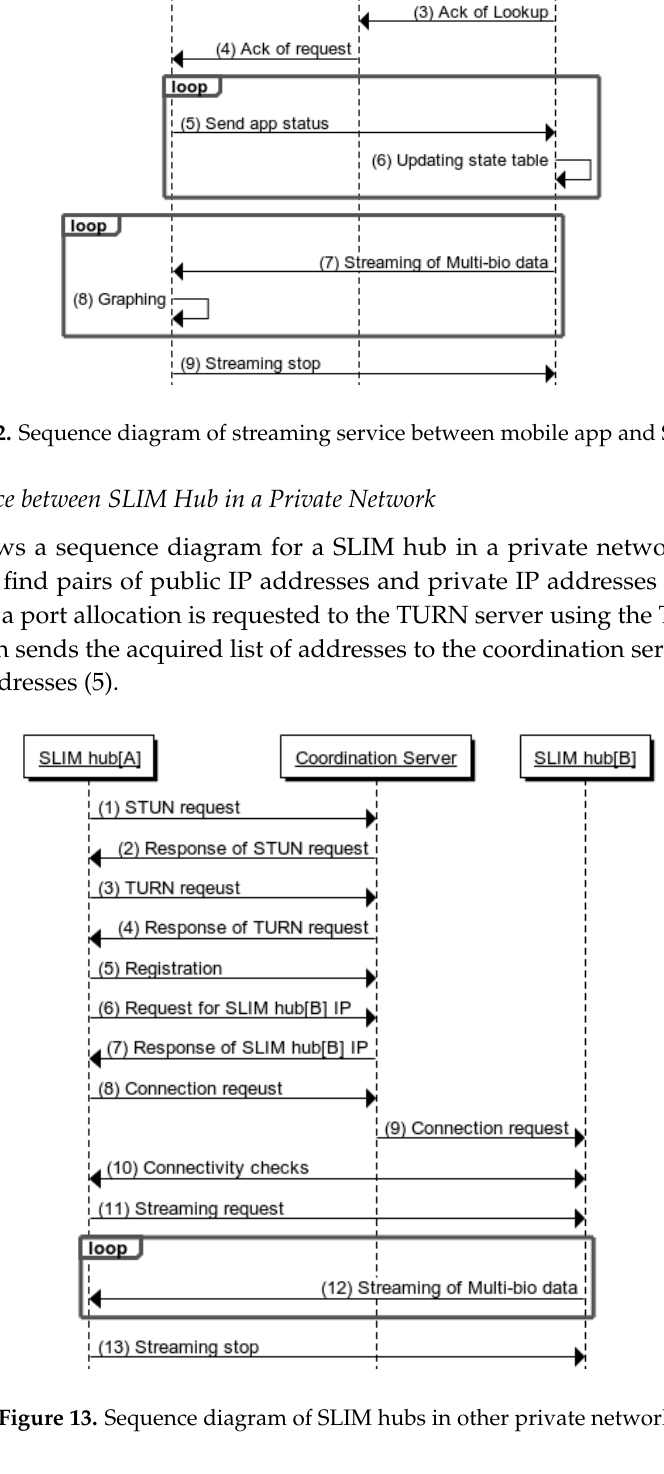
Figure 13. Sequence diagram of SLIM hubs in other private network.